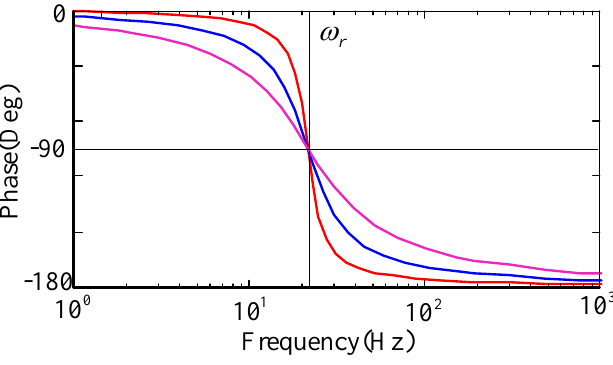
Figure 4. Phase response of PMLOSM.